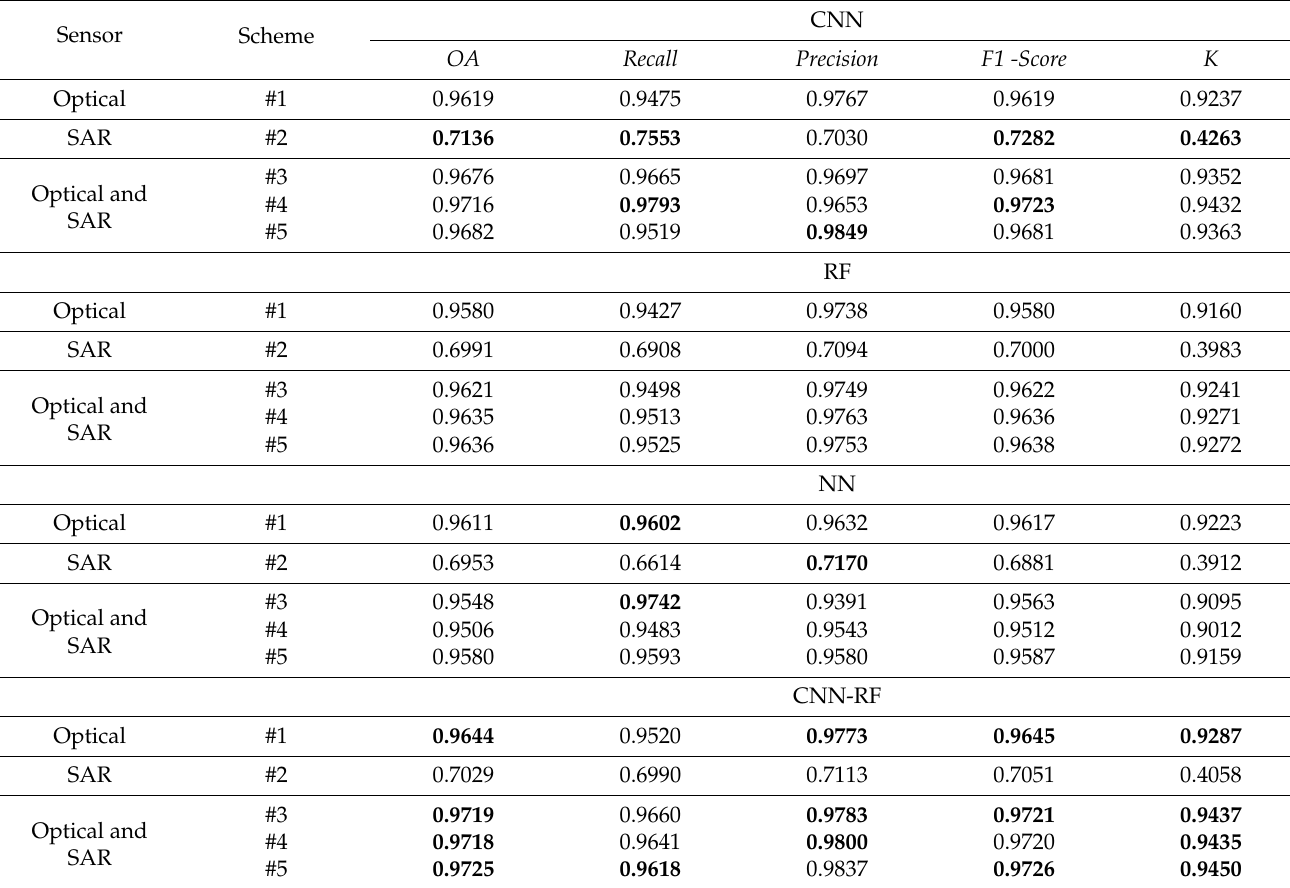
Table 3. The results of the performance of the burned area classification model using the CNN, RF, and NN methods, as well as the CNN-RF method for Schemes